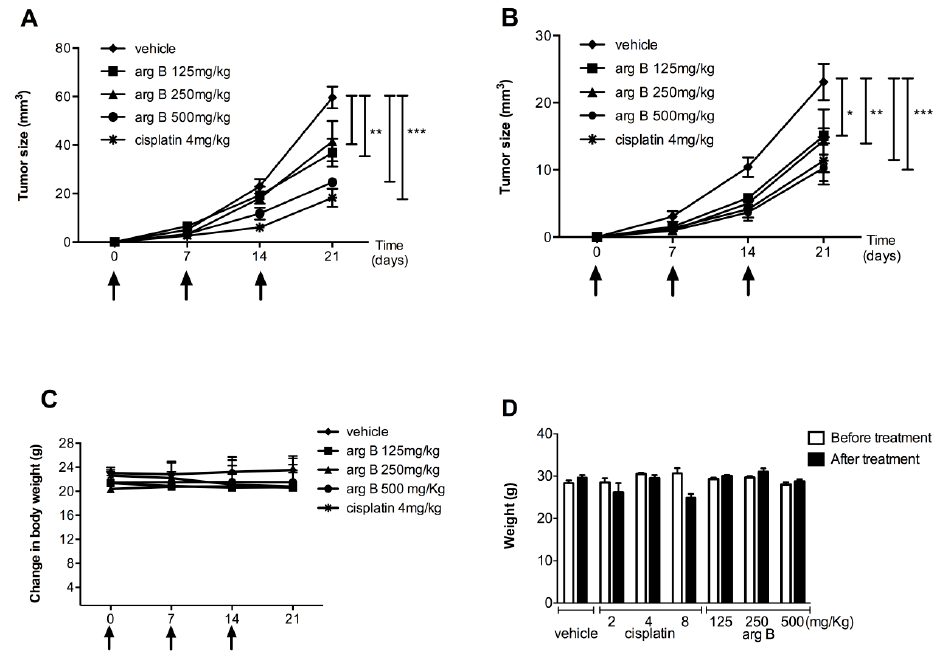
Figure 6. Evaluation of effects of argentatin B in vivo . Antitumor activity of argentatin B was evaluated in nu/nu mice implanted with HCT-15 ( A ) and PC3 ( B ) cells. Mice received the indicated concentrations of argentatin B, cisplatin or sesame oil (vehicle) at days 0, 7, and 14. Each point represents the average ± SEM of six animals. Significant differences of * p < 0.05, ** p < 0.001, and *** p < 0.0001 vs. vehicle are shown (one-way ANOVA test, and Tukey-Kramer post-test); ( C ) Evaluation of body weight change in nu/nu mice; ( D ) The toxicity of argentatin B was tested in groups of three CD-1 mice. The indicated doses of argentatin B, cisplatin or vehicle were administered intraperitoneally every week. The weight of the mice was recorded every other day. Error bars indicate the standard error of the mean.